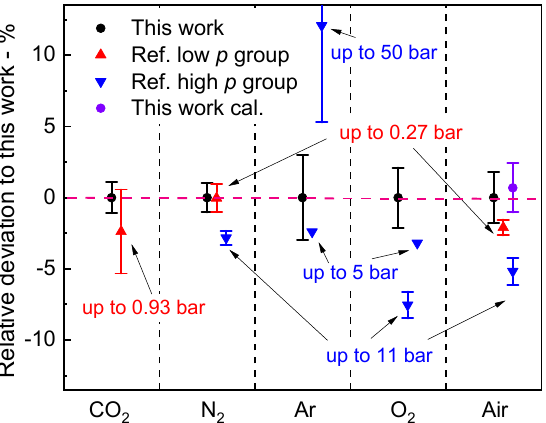
Figure 7. Comparison of our results with data from the literature, y-axis: percentage difference using present study as a reference. Red up-pointing triangle: data from literature measured in low pressure group, Blue down-pointing triangle: data from literature measured in high pressure group.